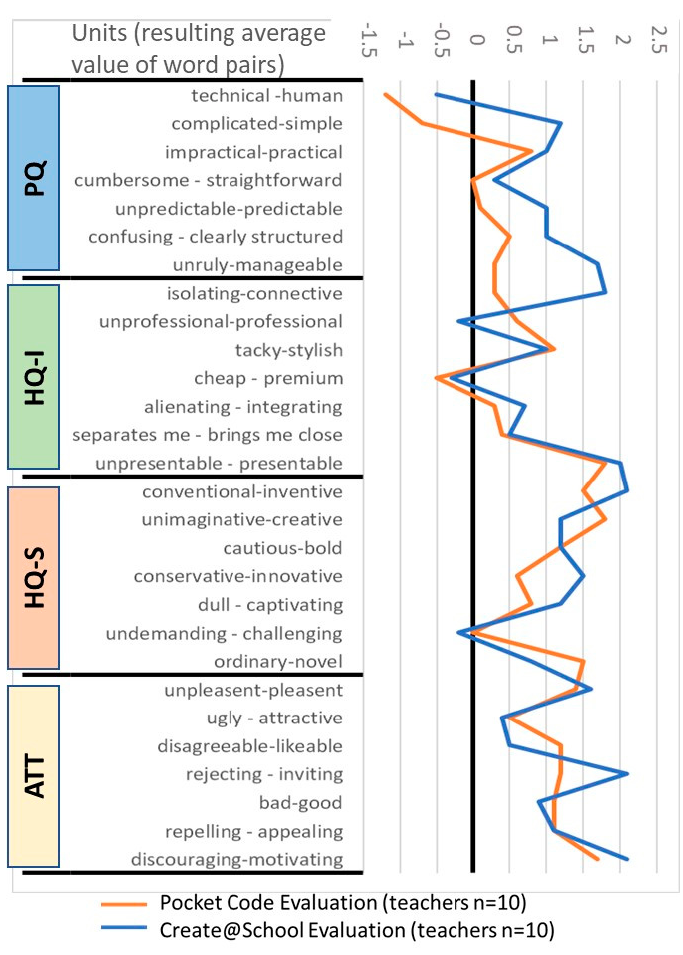
Figure 3. Diagram of the average of word pairs averages grouped by pragmatic qualities (PQs), hedonic identity quality (HQ-I), hedonic stimulation quality (HQ-S), and attractiveness (ATT) for the study